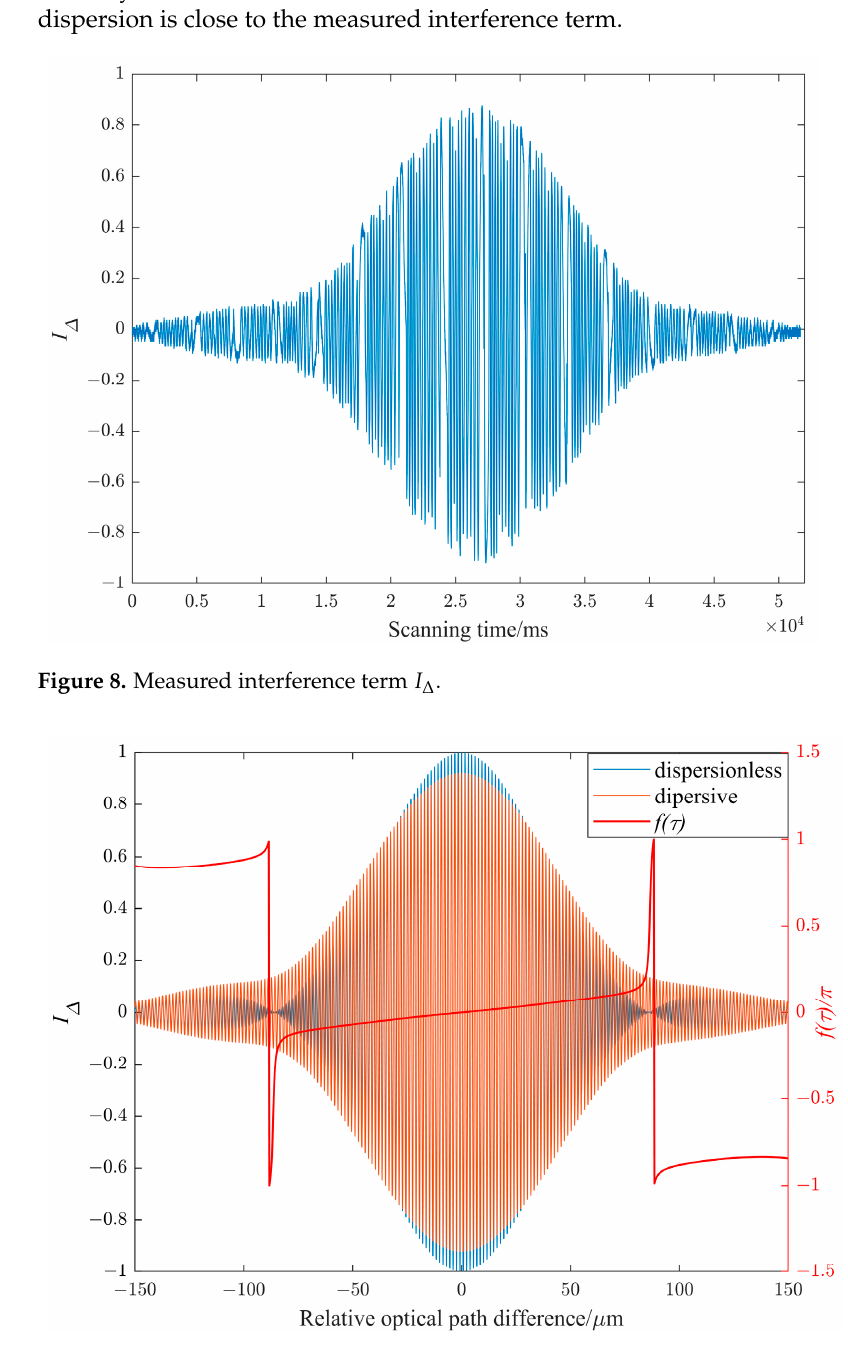
Figure 9. The simulated interference term I ∆ , the phase f ( τ ) associated with the spectral shape in the absence of dispersion, and the interference term I ∆ in the presence of dispersion. From the simulation analysis of Section 2.3, it can be seen that the phase difference between the two interferometric signals can be determined from the values of Rmax m and n Rmin m calculated from the adjacent extrema in the region of approximately linear variation n of the envelope shape. After normalizing the simulated interference terms in Figure 9, the interval in which the envelope shape varies approximately linearly is [0.5, 0.62]. Therefore, the phase difference of the two interference signals can be calculated using the extrema measured within [0.5, 0.62] of the normalized interference term in the